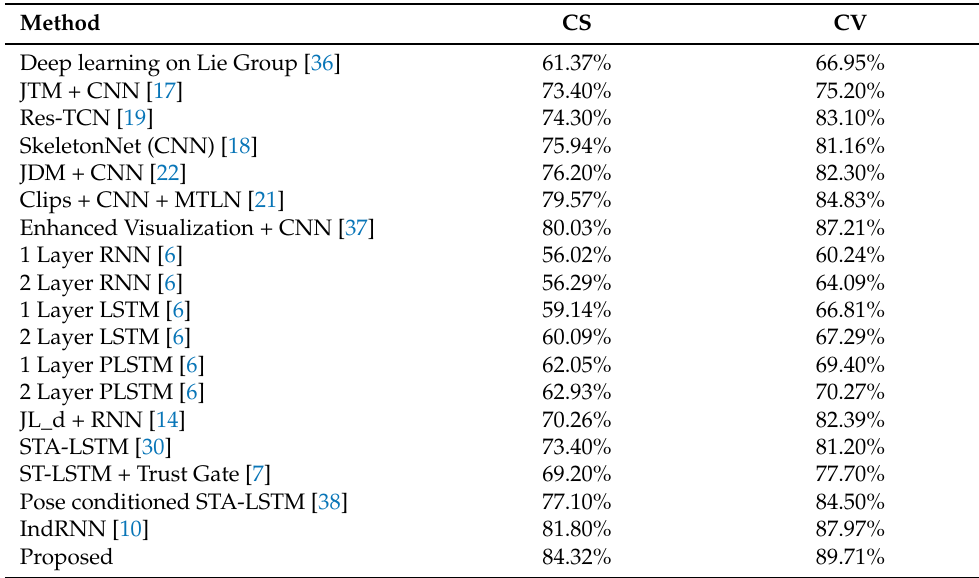
Table 2. Results of all skeleton-based methods on NTU RGB+D